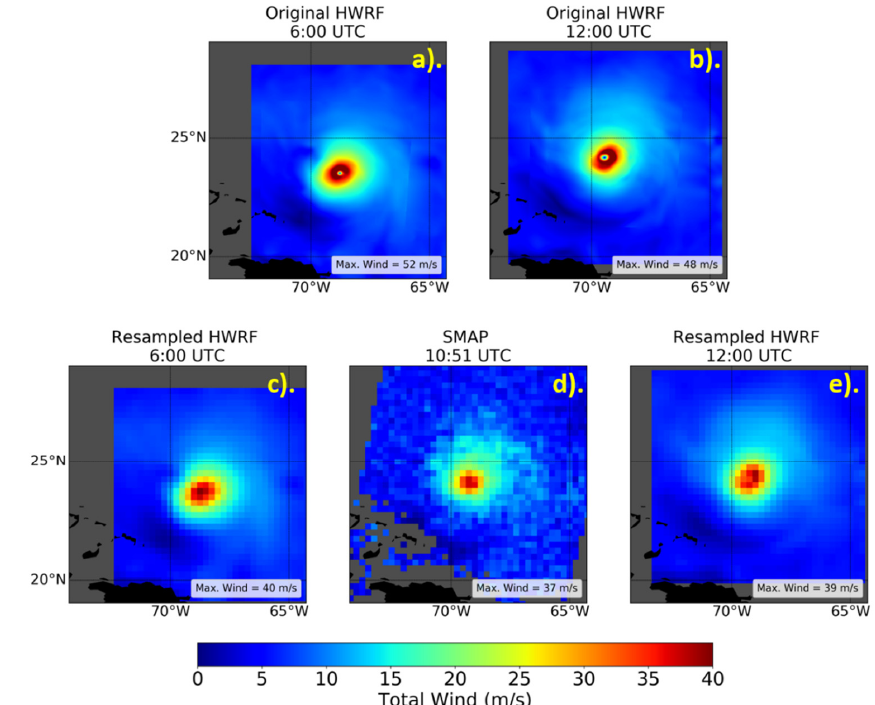
Figure 5. Comparison of SMAP and HWRF winds for Hurricane Dorian on 30 August 2019 for a SMAP pass at 10:51 UTC. Top panels: the HWRF winds before resampling for the HWRF analysis times before ( a ) and after ( b ) the corresponding SMAP pass. Bottom panels: the resampled HWRF winds at analysis times before ( c ) and after ( e ) the SMAP pass ( d ).